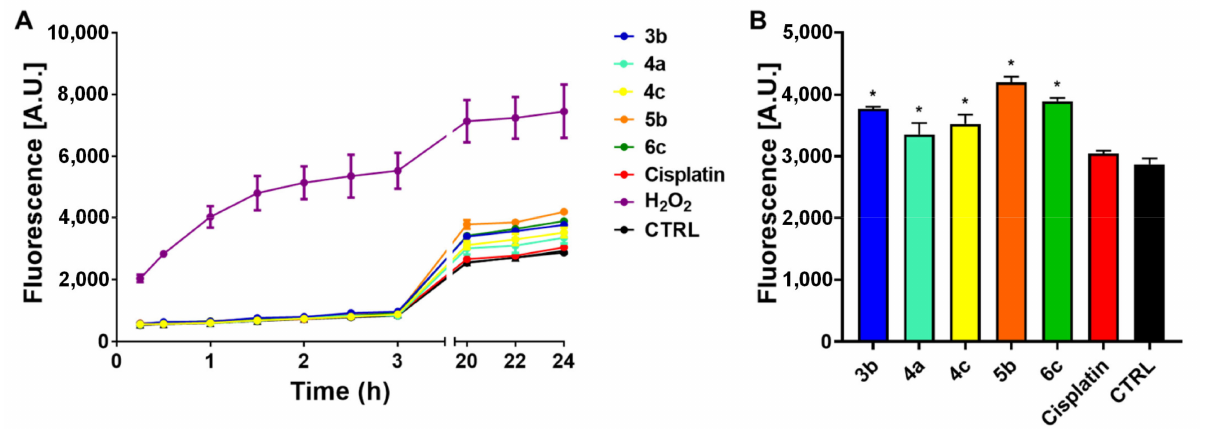
Figure 3. Fluorescence kinetic measurements of intracellular reactive oxygen species (ROS). A2780 cells incubated ( A ) up to 24 h and ( B ) for 24 h with 20 µ M of diiron complexes at 37 ◦ C and 5% CO 2 . Results are expressed as the mean of three analyses with standard deviation. Values marked with * are significantly different from the control (* p <